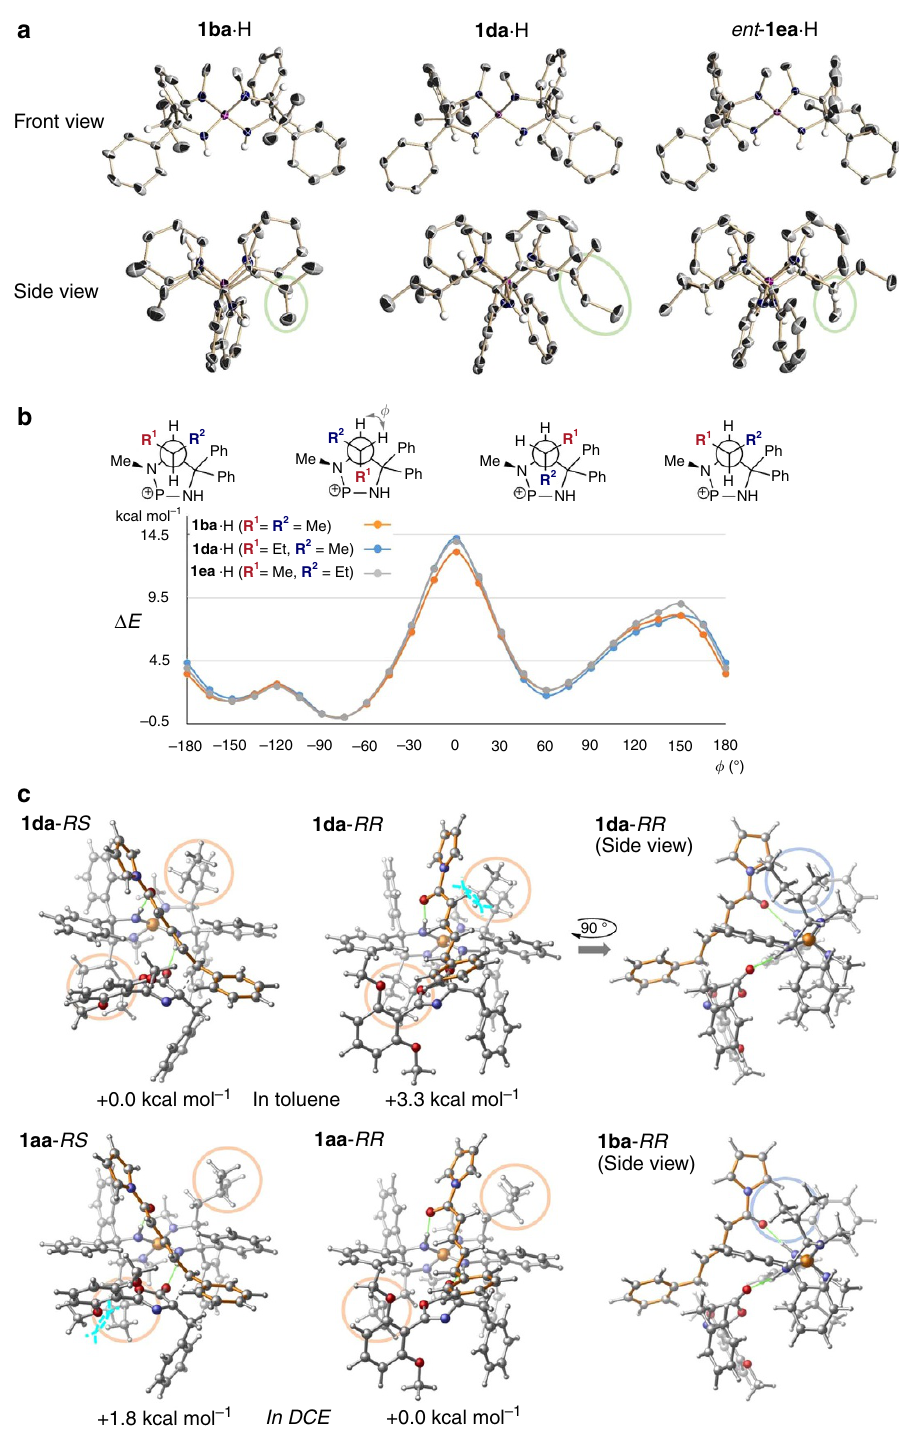
Figure 5 | Structural elucidation of aminophosphonium ions 1 . H and computational analysis of transition-state structures of the diastereodivergent 1,6-addition reactions. ( a ) ORTEP diagrams of aminophosphonium ions 1 (cid:4) H. ( b ) Energy profile along with rotation around C–C axis of the stereogenic carbon of 1 (cid:4) H and the branching carbon of alkyl side chain. ( c ) Transition-state structure models for the C–C bond-forming step from DFTcalculation and relative Gibbs free energies at PCM-B3LYP-D3/6-311 þþ G**//B3LYP/6-31G* level.